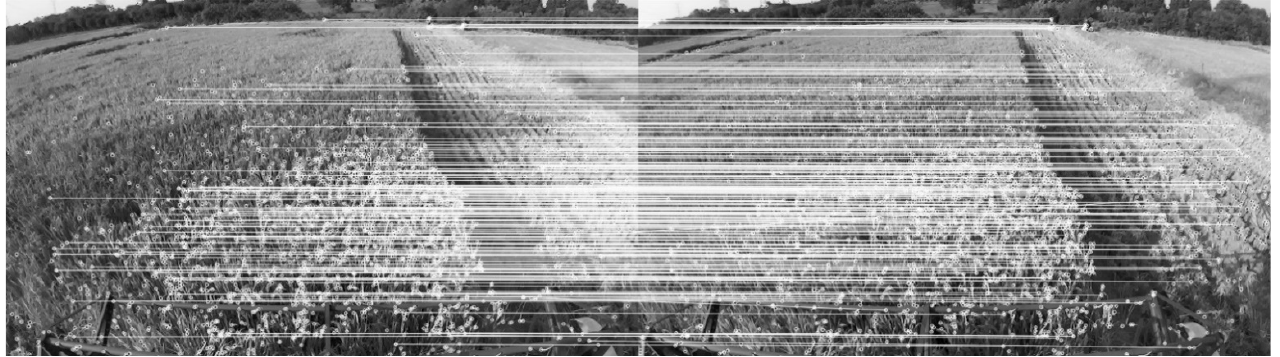
Figure 2. A total of 2000 FREAK features were extracted and 257 pairs were successfully